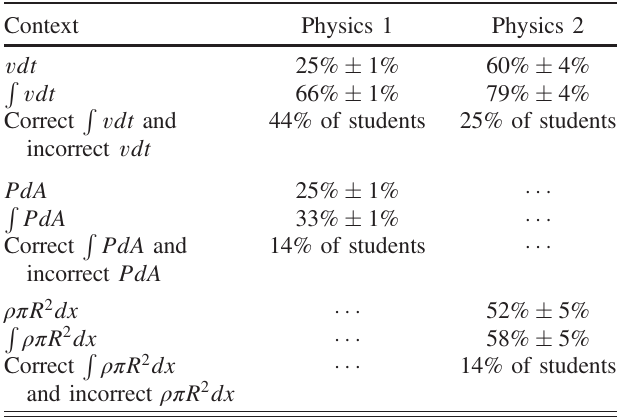
TABLE VI. Percentage of students demonstrating conceptual understanding of most- and least-familiar differential products and integrals in both Physics 1 and Physics 2. In the most familiar R vdt in both Physics 1 and Physics 2), students were context ( more likely to make correct physical sense of the integral while failing to make sense of its differential product, when compared R PdA in Physics 1 to the same task in the least familiar contexts ( R ρπ R 2 dx in Physics 2). These data support the hypothesis and that familiarity is being used to prop up correctness when possible, but when context is no longer accessible from memory or prior experience, students who are unable to demonstrate understanding of the differential product are less likely to demonstrate understanding of its corresponding